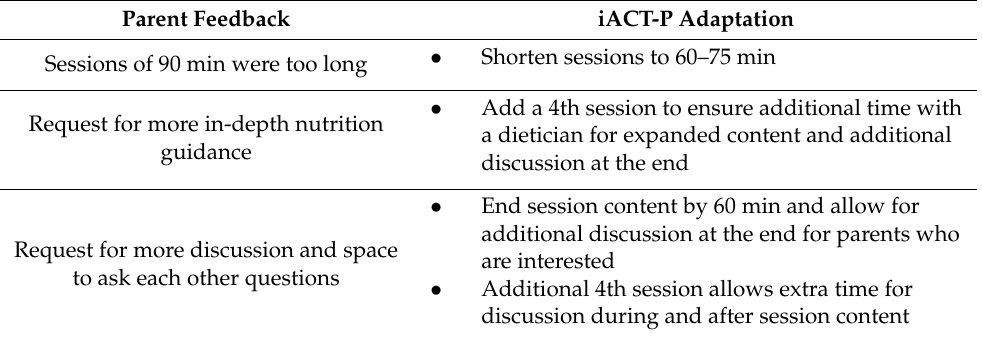
Table 4. Suggested adaptations to the iACT-P